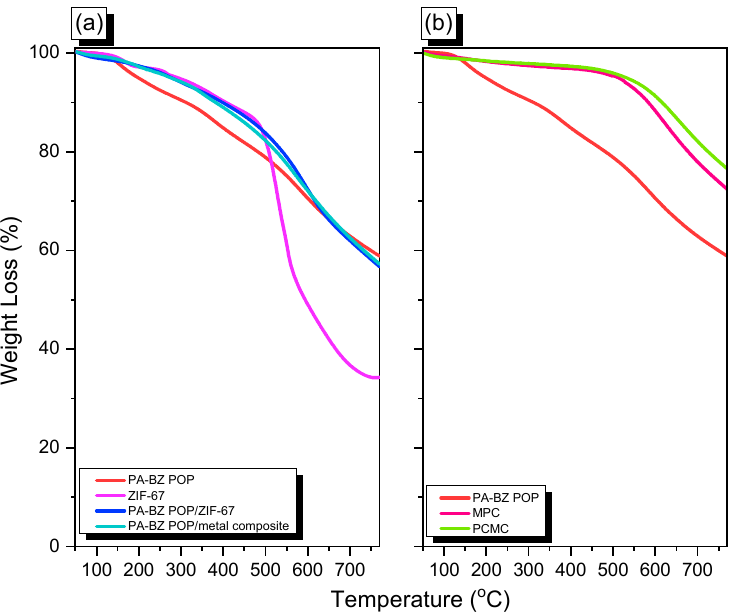
Figure 6. TGA profiles of the ( a ) PA-BZ POP, ZIF-67, PA-BZ POP/ZIF-67, and PA-BZ POP/metal composite and ( b ) PA-BZ POP, MPC, and PCMC. The porosities and pore size diameter of MPC, ZIF-67, and PCMC materials were identified using N 2 sorption isotherms (Figure 7). The pure MPC material provided a type